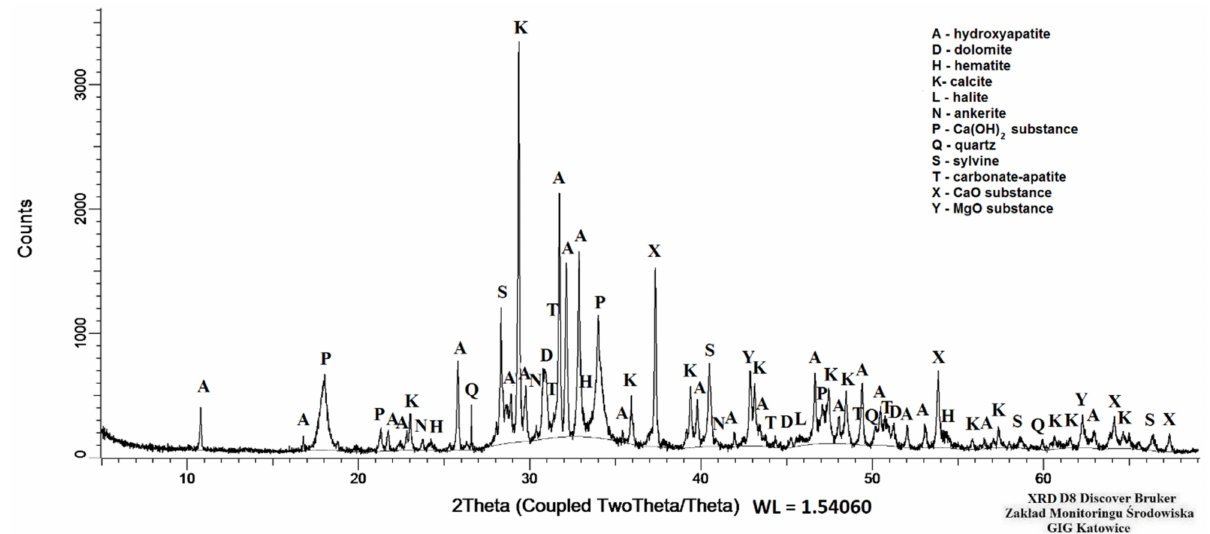
Figure 2. Ash diffraction photograph (sample PMA).